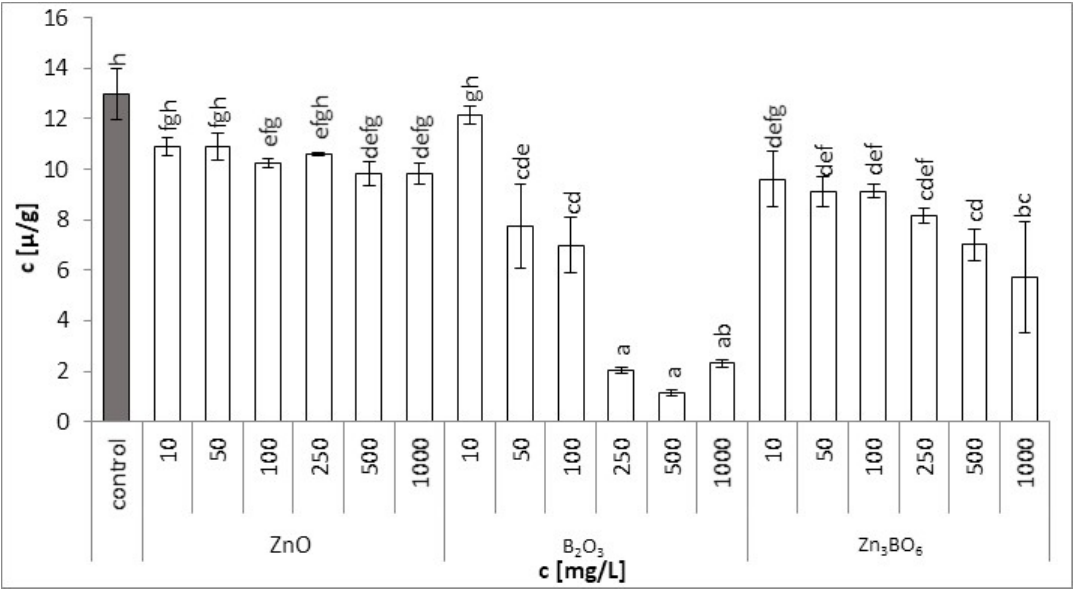
Figure 4. Total carotenoid contents in L. minor plants after 7 days of growth in the solutions supplemented with ZnO, B 2 O 3 or Zn 3 BO 6 , respectively, at concentrations of 10, 50, 100, 250, 500 and 1000 mg/L. Control plants grew in Steinberg solution; standard deviation is represented as ± S.D. ( n = 3), and two-way ANOVA test with Dunnett’s multiple comparisons was applied.